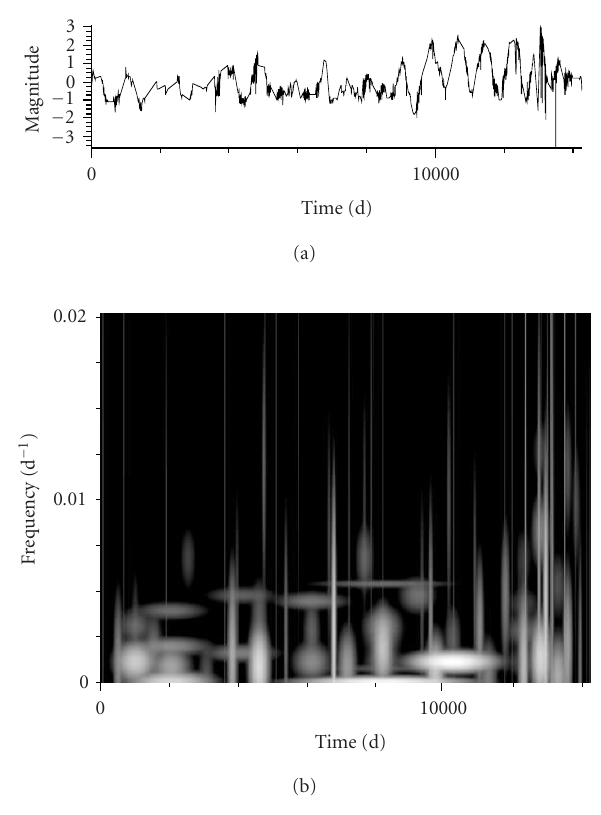
Figure 17: Time-frequency decomposition (b) of the S Persei sig- nal